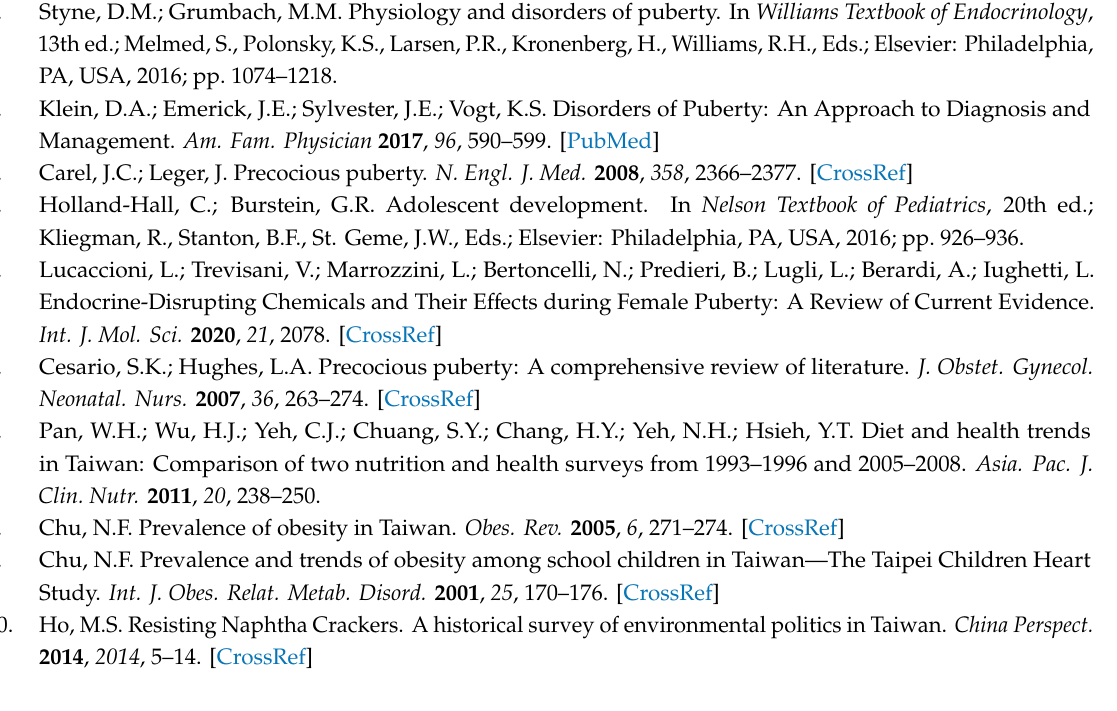
Table S1: Population number in this study, Table S2-1: Received tests within 1 year from diagnosis of